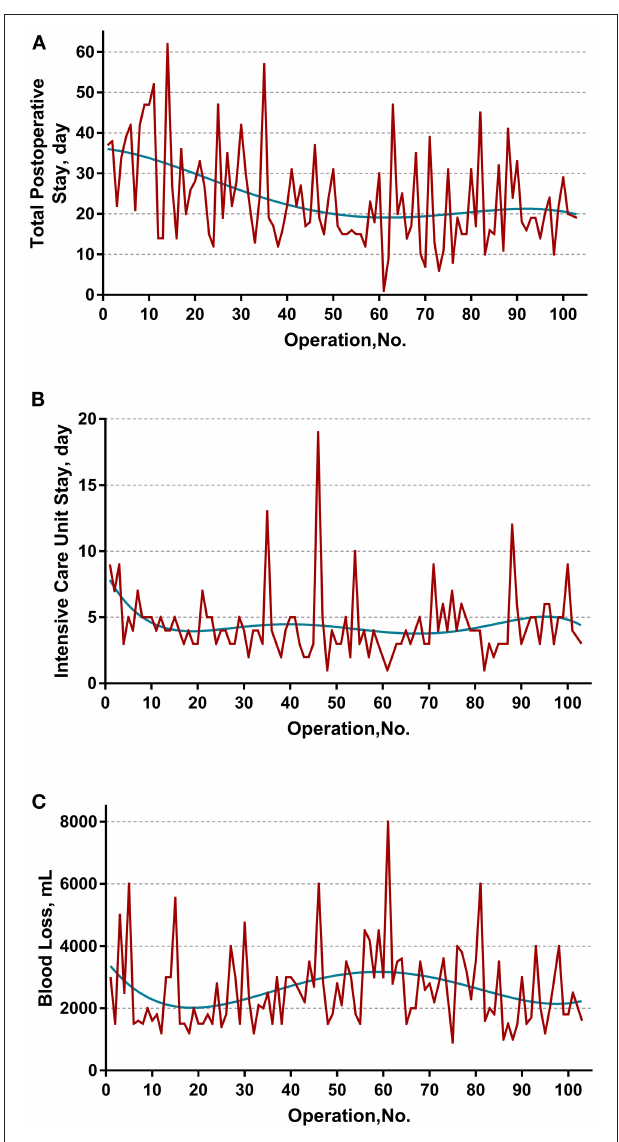
FIGURE 4 | Evolution of other secondary endpoints including (A) total postoperative stay, (B) intensive unit care stay, and (C) blood loss were plotted against cases of ELRAs performed. The blue curve represents the curve of best fit for the plots. No obvious patterns were observed by visual